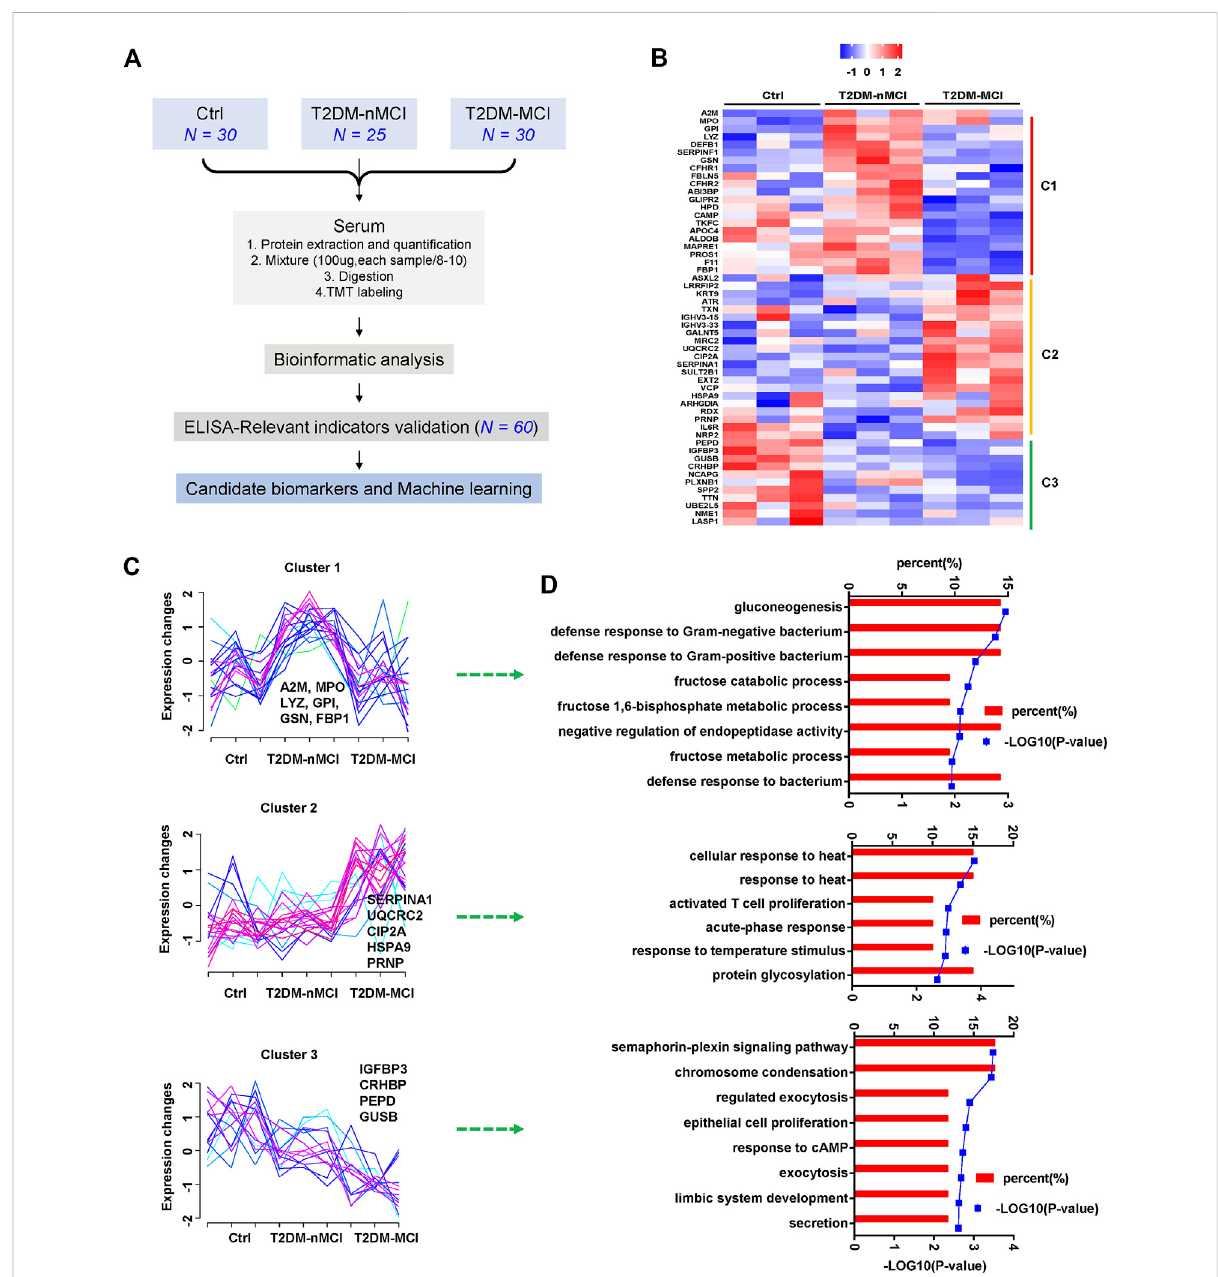
FIGURE 1 Disease stage-dependent proteins in the plasma of T2DM patients identi fi ed by proteomics. (A) Strategy for pro fi ling of the serum proteome and subsequent veri fi cation of candidate biomarkers. (B) Heatmap of the proteomics dataset based on the changed proteins. The TMT intensities (Z-score transformed) of each protein (rows) across three disease groups (columns) are indicated in a colored scale. (C) Clustering analysis of changed proteins. Each line represents the change trend of one protein. The intensity of each protein is Z-score-transformed. (D) Enrichment analysis of biological processes for each cluster